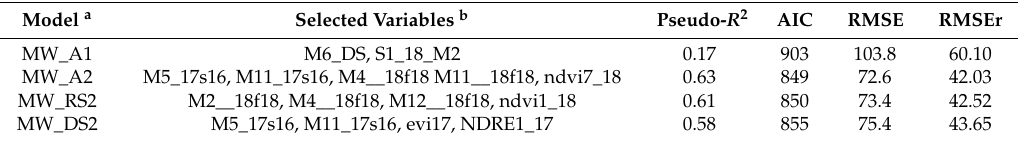
Table 6. Fitted models, selected variables from weighted mean approach (MW), Pseudo- R 2 , AIC, RMSE, and RMSEr.